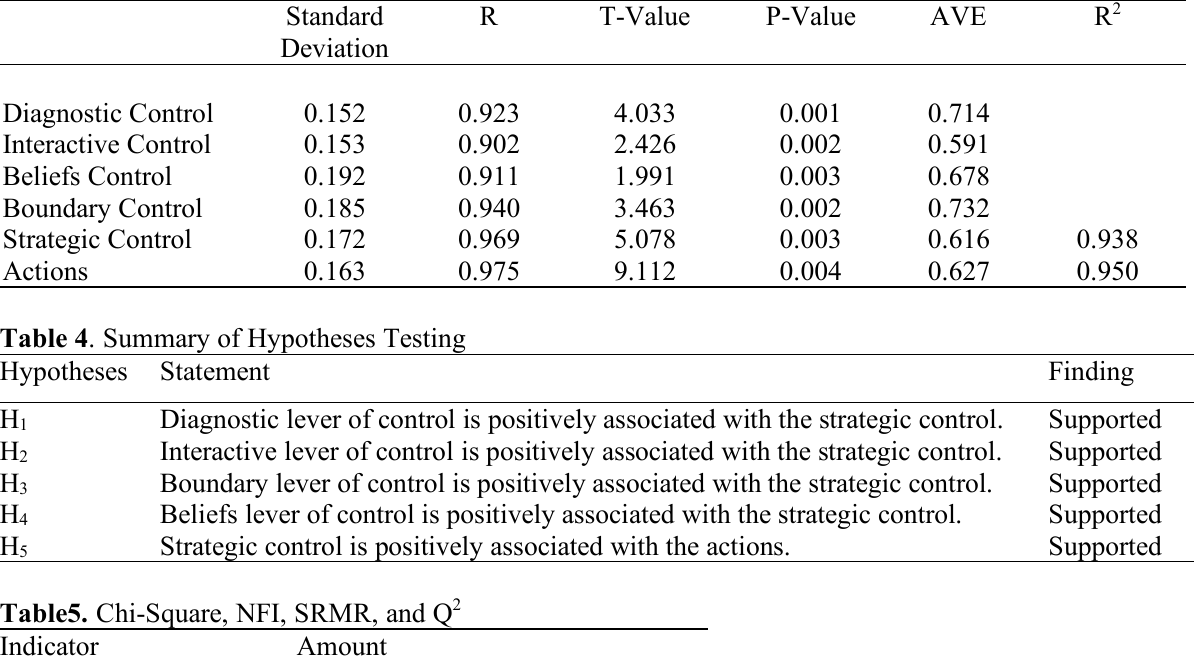
Table3. Path Coefficient, T-Value, R 2 , and SRMR